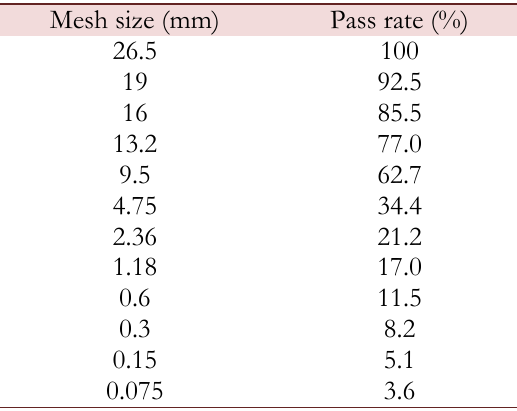
Table 3: Synthetic Aggregate Gradation of Cement Stabilized